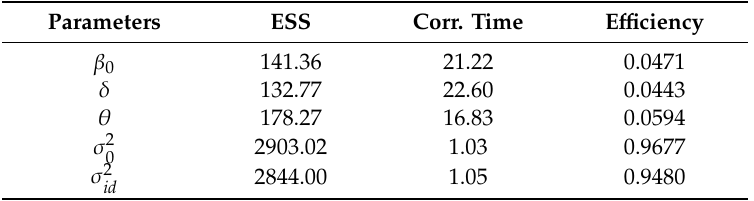
Table 5. E ff ective sample